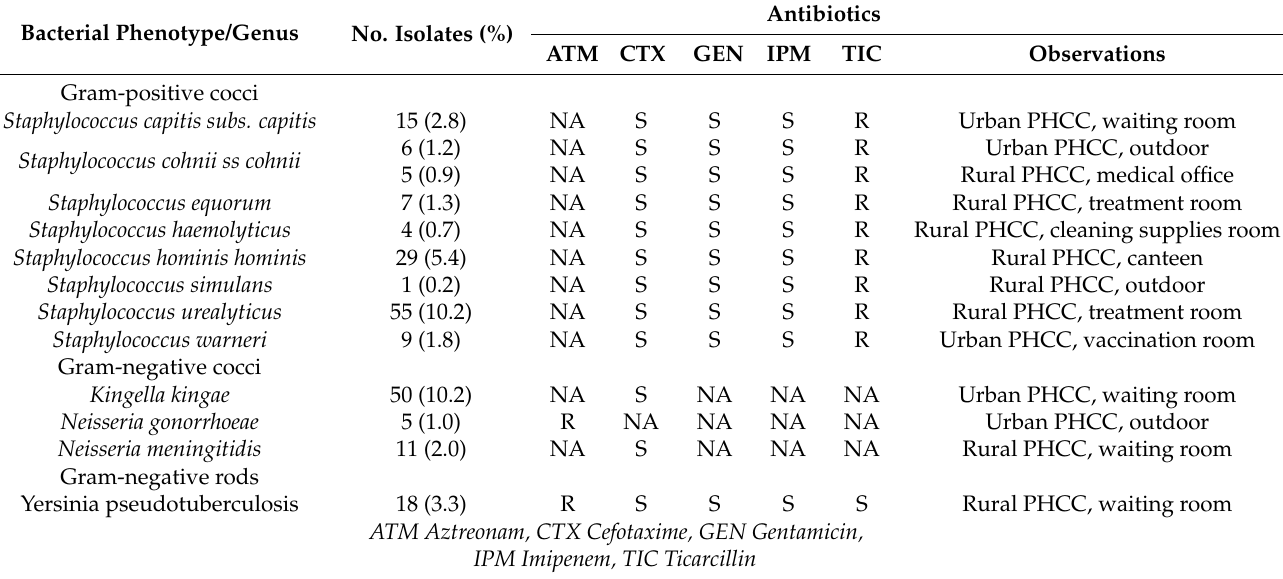
Table 4. Antimicrobial resistance of airborne bacterial isolates from Rural and Urban PHCC. Bacterial